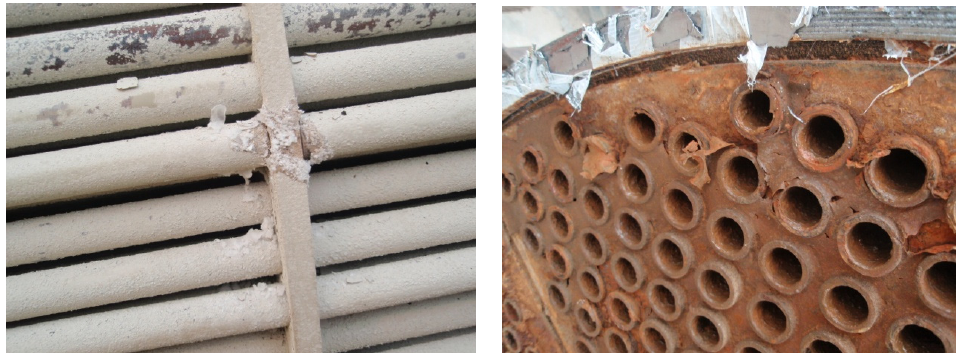
Figure 1. Corrosion morphology of acid-related heat exchanger tube bundles.